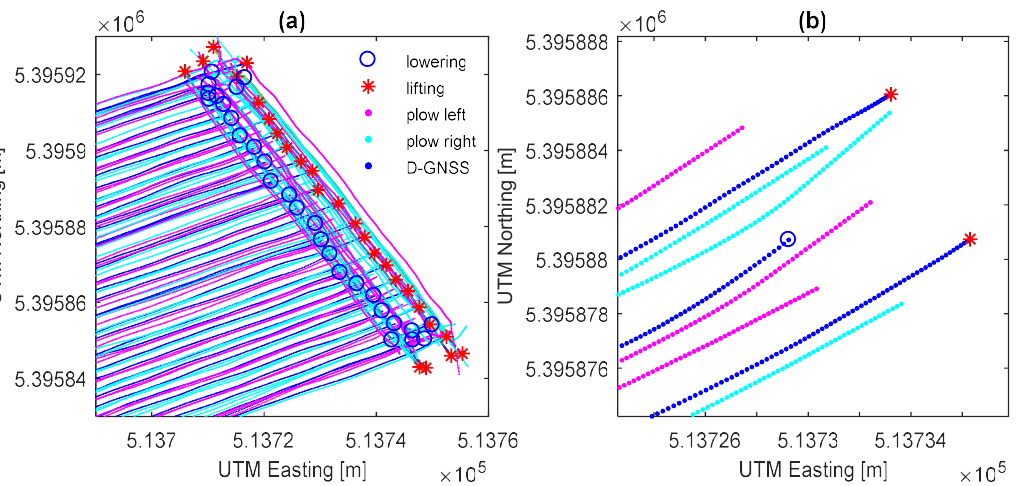
Figure 13. ( a ) Passes with points representing the plow’s lateral edges; and ( b ) a zoom area with three exemplary tracks.